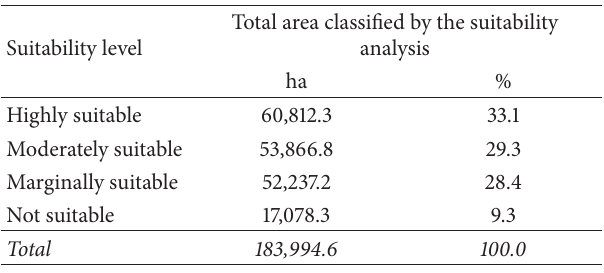
Table 5: Distribution area of suitable land for agriculture in Tuban Regency.